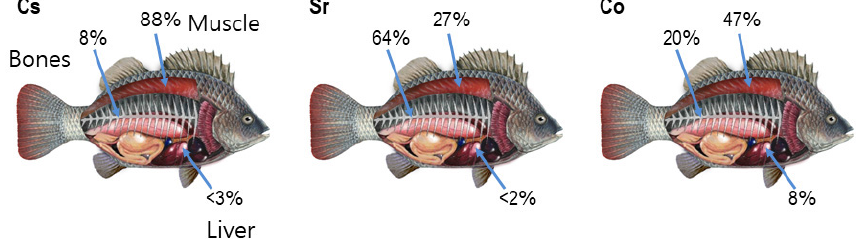
Figure 1. Distribution of accumulated activities of isotopes Cs, Sr and Co in muscle, bone and liver estimated from data (Yankovich, 2003; Yankovich et al., 2010).